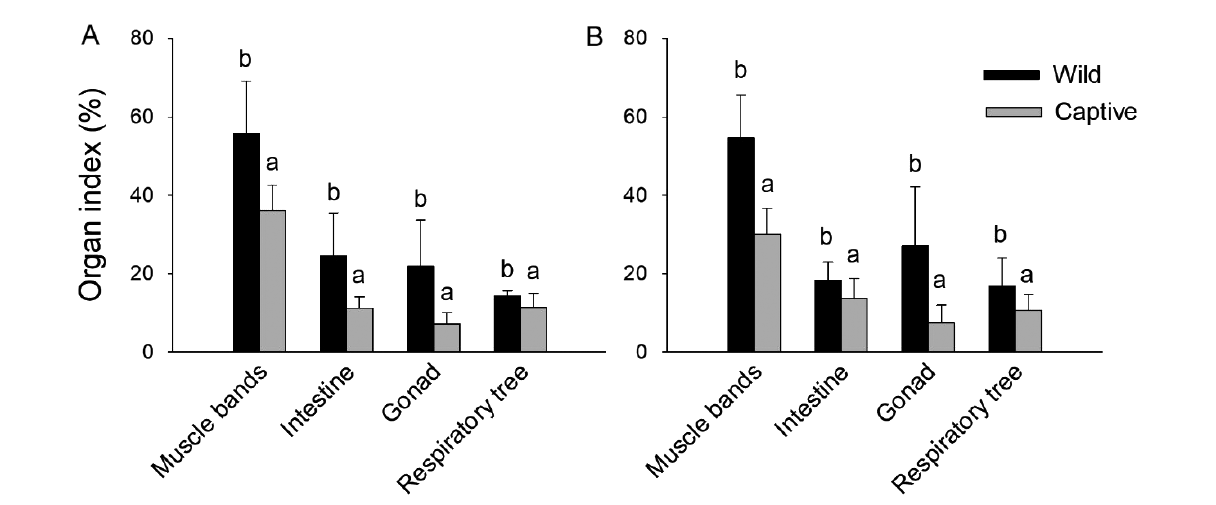
Fig. 2. Organ indices of (A) male and (B) female individuals of wild and captive (45 mo under IMTA conditions) Cucumaria frondosa . Data are shown as means ± SD (n = 10 for wild and n = 8 for captive in A; n = 14 for wild and n = 8 for captive in B). Means with different letters are significantly different ( t -test, p < 0.05)